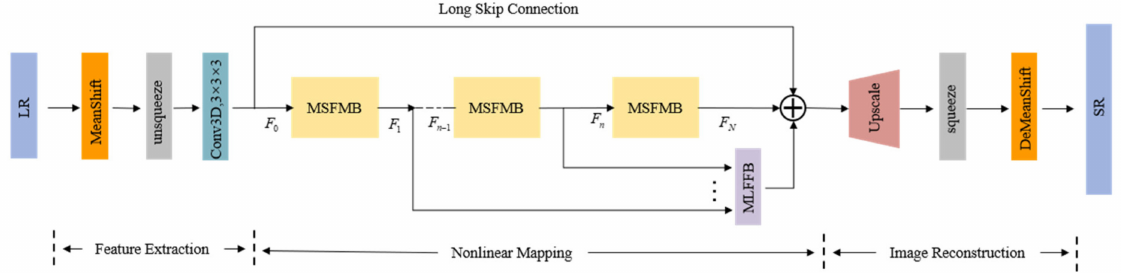
Figure 1. Whole architecture of the proposed MSFMNet. Colored boxes of the same color represent the corresponding relationship. The above structure is described in detail